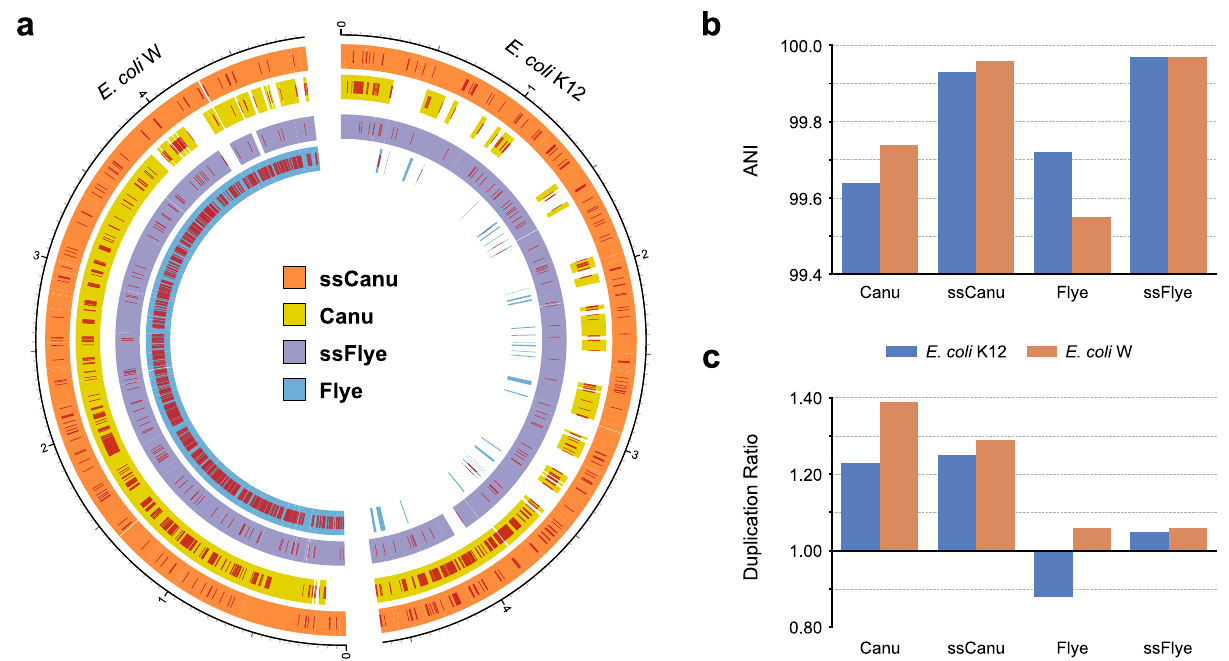
Fig. 2 Mock3 dataset assembly statistics. a Circos 58 graph displaying the coverage and SNV-rich regions (single-nucleotide errors) of the strain-oblivious assemblies (Flye and Canu) and their strain-separated counterparts obtained with Strainberry (ssFlye and ssCanu, respectively) compared to the reference sequences of the two E. coli strains present. The external graduated scales re fl ect the genomic positions of the corresponding reference genomes. b Average nucleotide identity (ANI) and c duplication ratio of